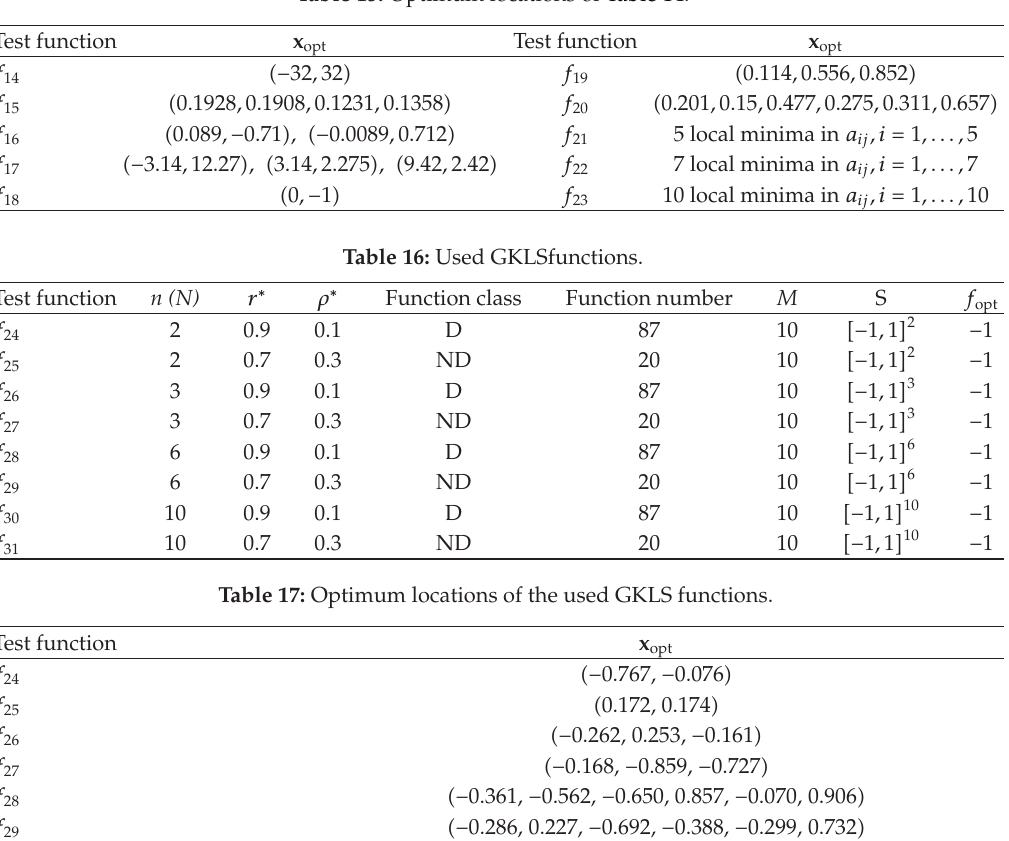
Table 15: Optimum locations of Table 14.